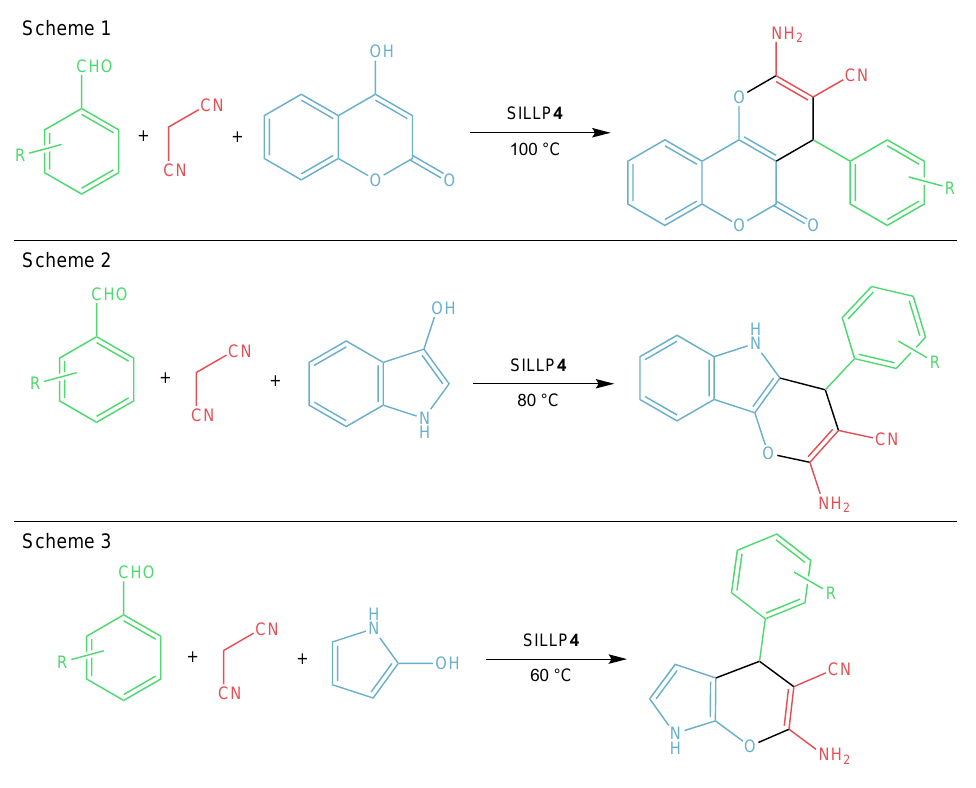
Figure 12. Brønsted-type SILLP based on silica material in the synthesis of 3,4 -dihydropyrano[c]chromenes (Scheme 1), pyrano[3,2-b]indoles (Scheme 2), and pyrano[2,3-b]pyrroles (Scheme 3).